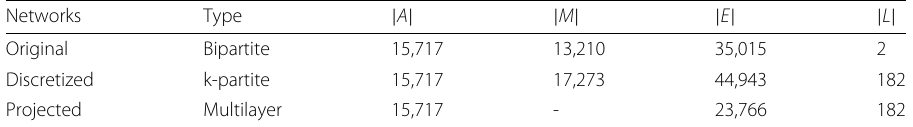
Table 2 Temporal text networks used in the case study and its basic properties: number of actors ( | A | ), number of messages ( | M | ), number of edges ( | E | ) and number of layers ( | L | )